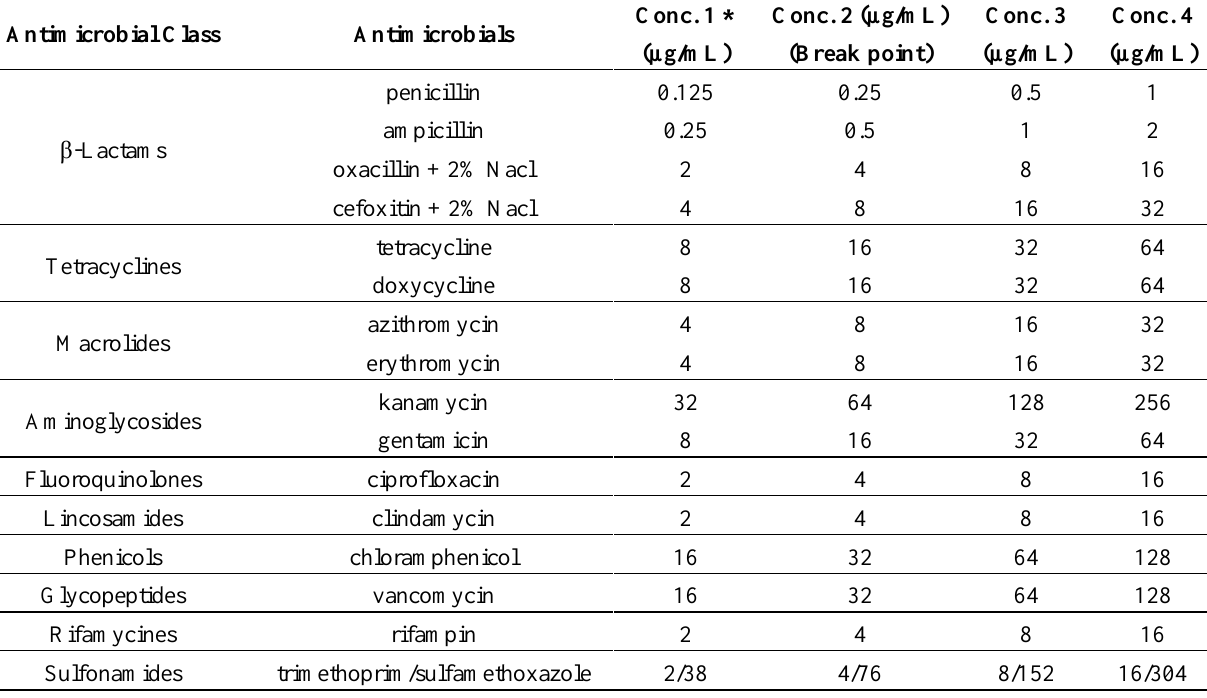
Table 2. A list of the 16 antimicrobials, their classes, concentrations used for susceptibility testing, and the breakpoints used for each